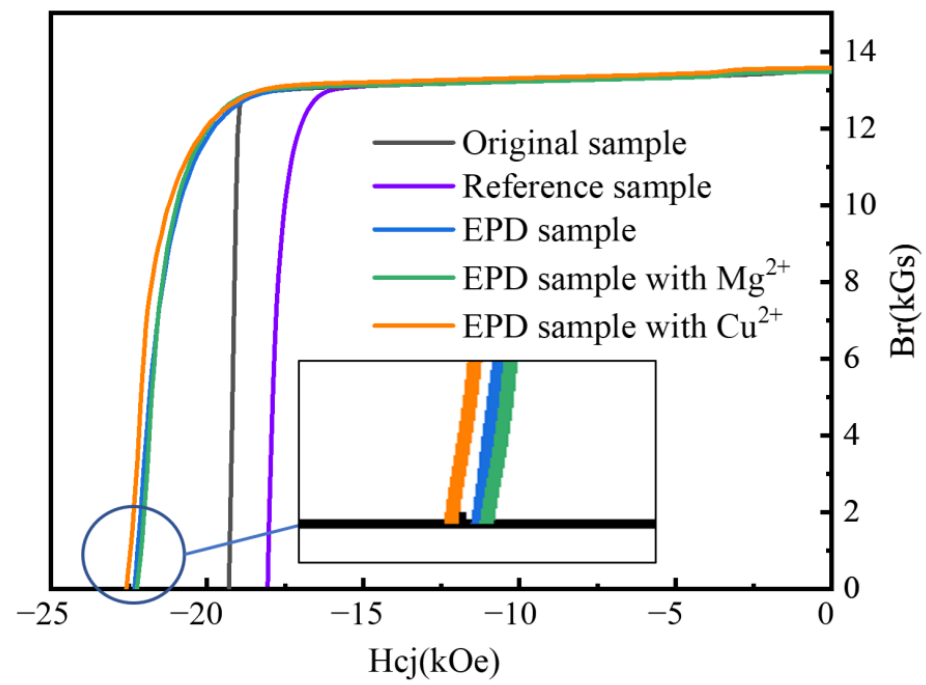
Figure 10. Demagnetization curves of magnet.